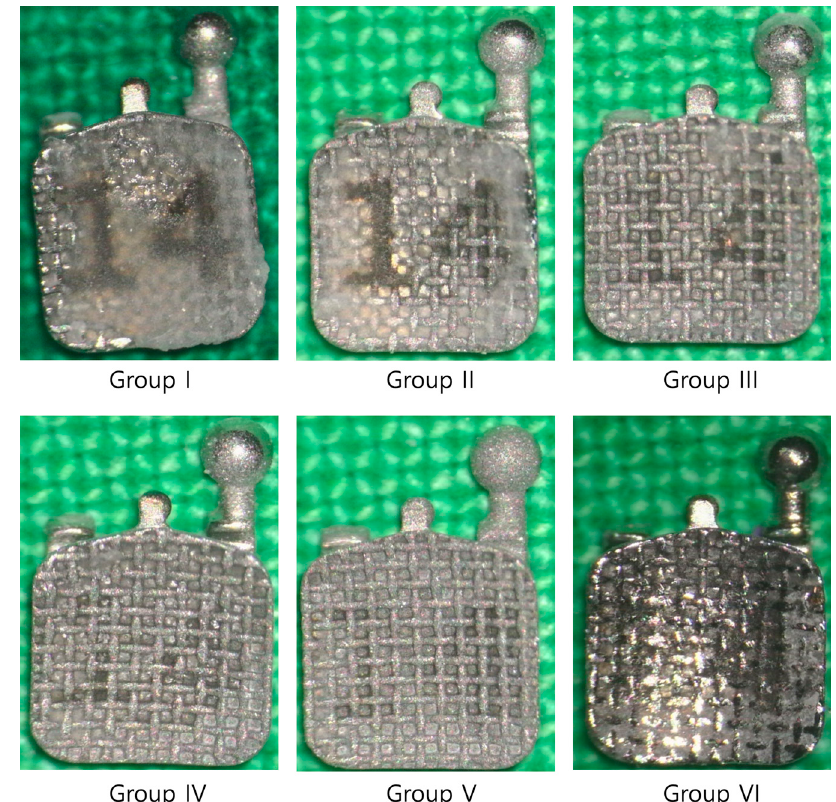
Figure 5. Microscopic photos of bracket bases. See Table I for group description. Magnification